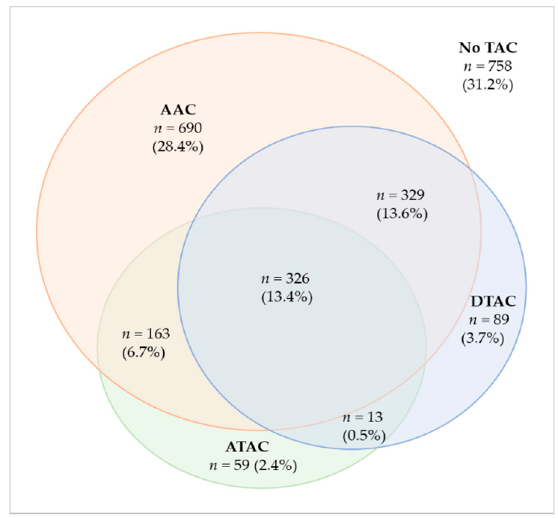
Cells 2021 , 10 , x 5 of 11 3.2. Calcium Distribution along Thoracic Aorta Overall, 1669 (68.8%) participants demonstrated TAC. A total of 1508 (62.1%) indi- viduals had AAC, which corresponds to 90.4% of the population with TAC. The preva-